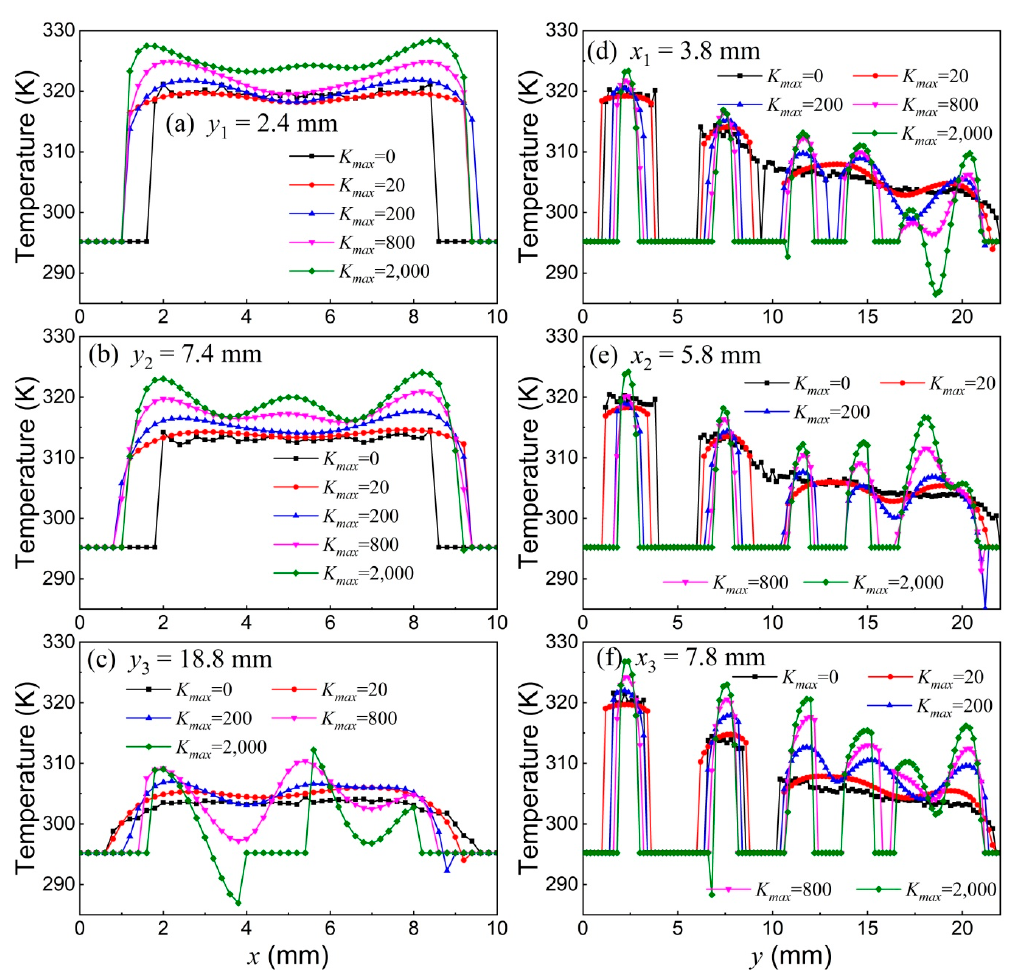
Figure 8. ( a – c ) Measured temperatures versus x for different K max values at different y positions. ( d – f ) Measured temperatures versus y for different K max values at different x positions. Symbols represent experimental results whereas solid lines are guides to the eye. Nanomaterials 2018 , 8 , x FOR PEER REVIEW